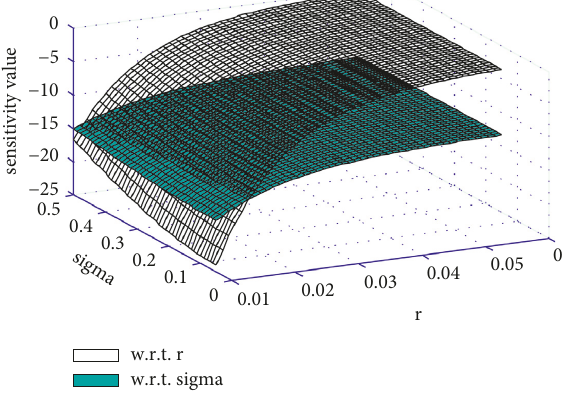
Figure 2: Sensitivity w.r.t. r and σ . Table 2: State changes of 28 investment